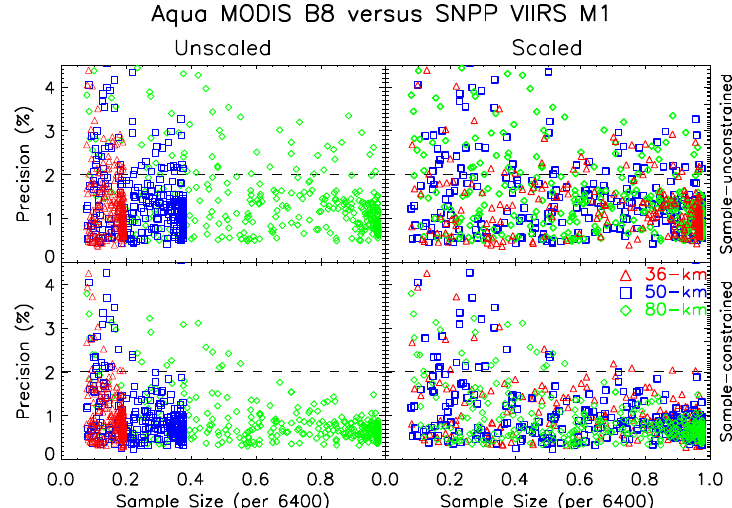
Figure 13. Scaling phenomenon in Aqua MODIS B8 versus SNPP VIIRS M1 for both sample- unconstrained and sample-constrained